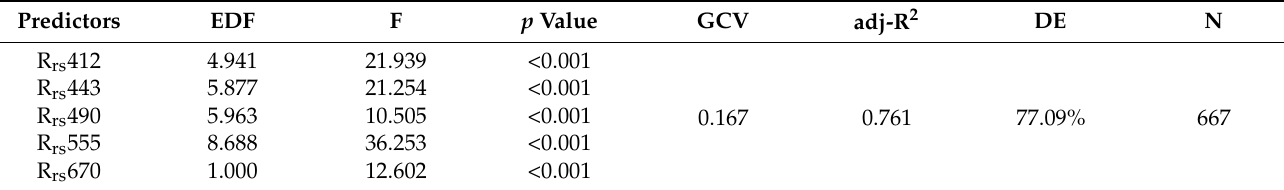
Table 13. Statistical summary of the fitted cryptophytes